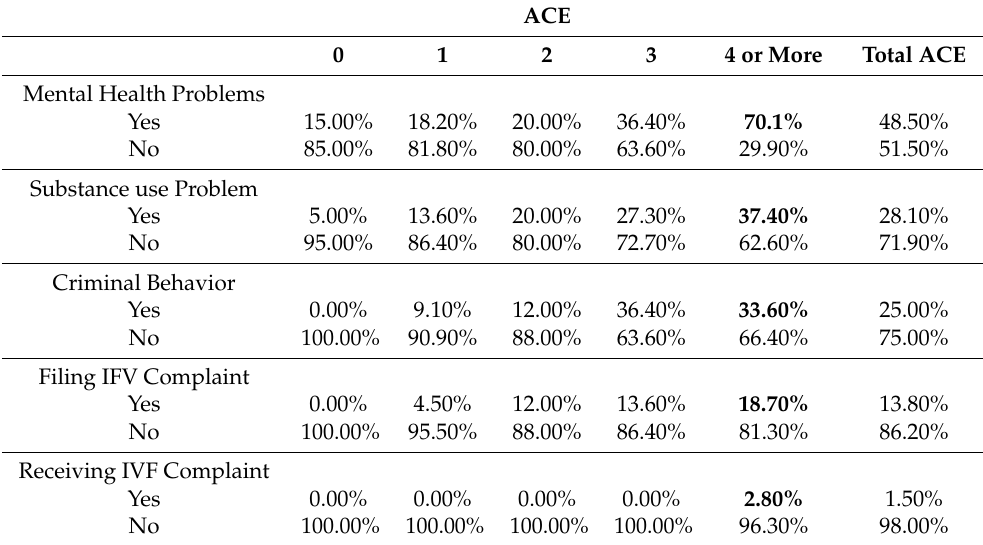
Table 3. Adverse Childhood Experiences and at least one Mental Health Problem, Substance Use Problem, Criminal Behavior, and